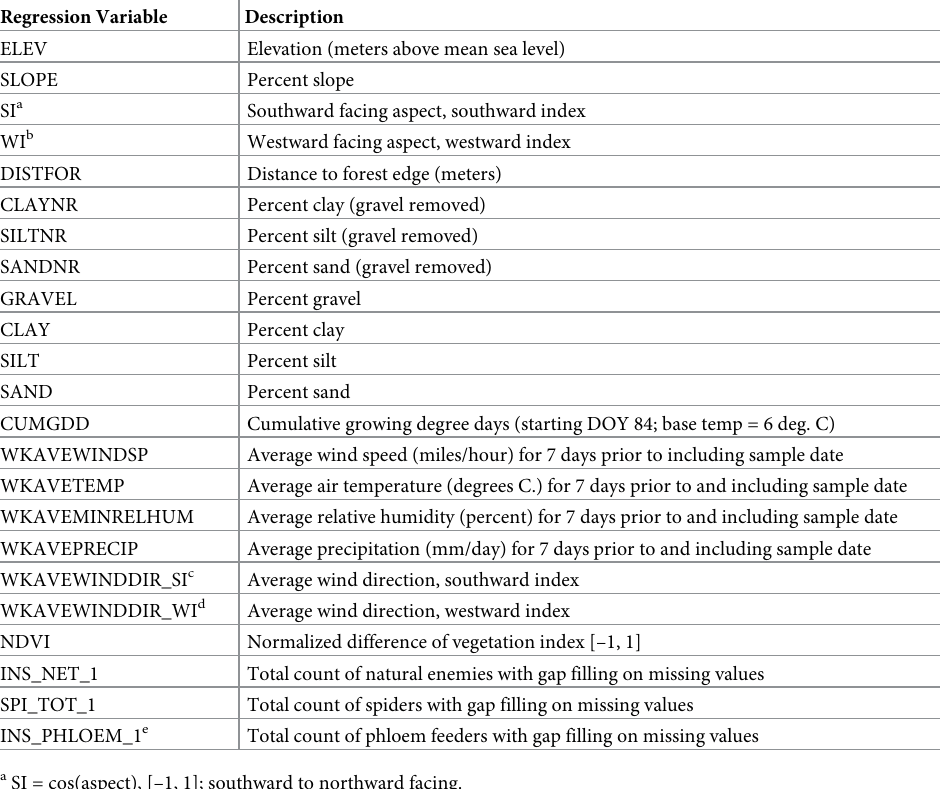
Table 1. Description of predictor variables used in initial regression